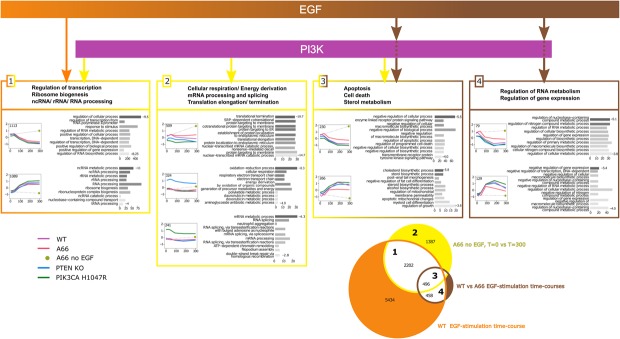
Summary diagram of PI3K mediated functions based on the analysis of WT cell lines. Arrow colours correspond to colours of the Venn diagram in the bottom-right corner of the figure. The Venn diagram represents an overlap of three gene sets identified by differential expression analysis (see text for description). Gene expression time course profiles represent the average of many genes (exact number is shown in each profile). Only the gene clusters with significant GO enrichment are shown. Values on the right of GO bar charts are log10(P-value) for the corresponding terms. Grey levels reflect the significance. Bar lengths represent the number of genes annotated by the GO term.